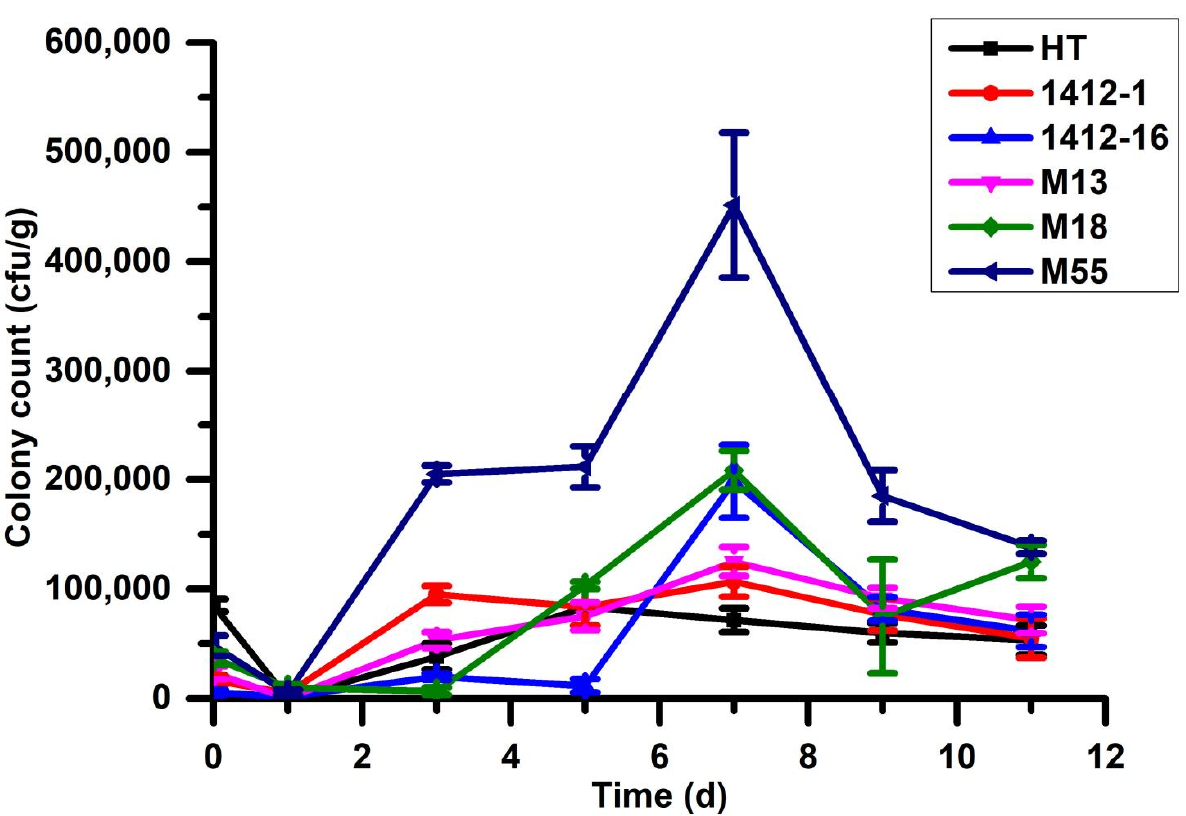
Figure 4. Population dynamics of I. cateinannulata on the leaf surfaces of six buckwheat cultivars (in CFUs/g).